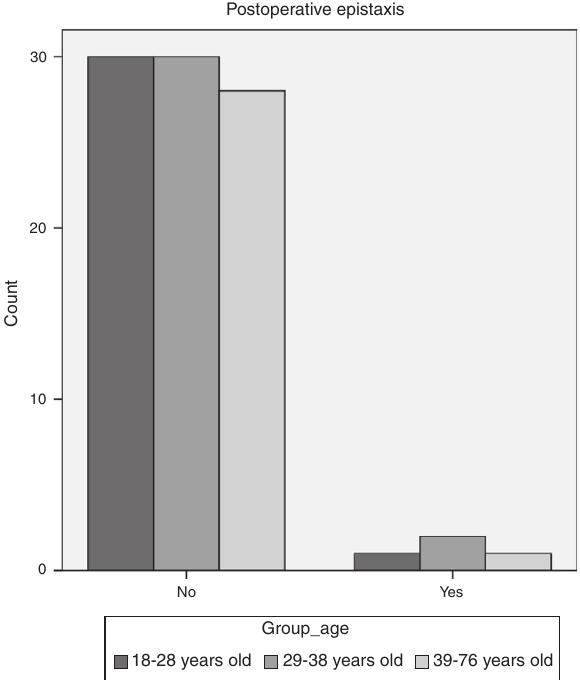
Figure 4 Postoperative